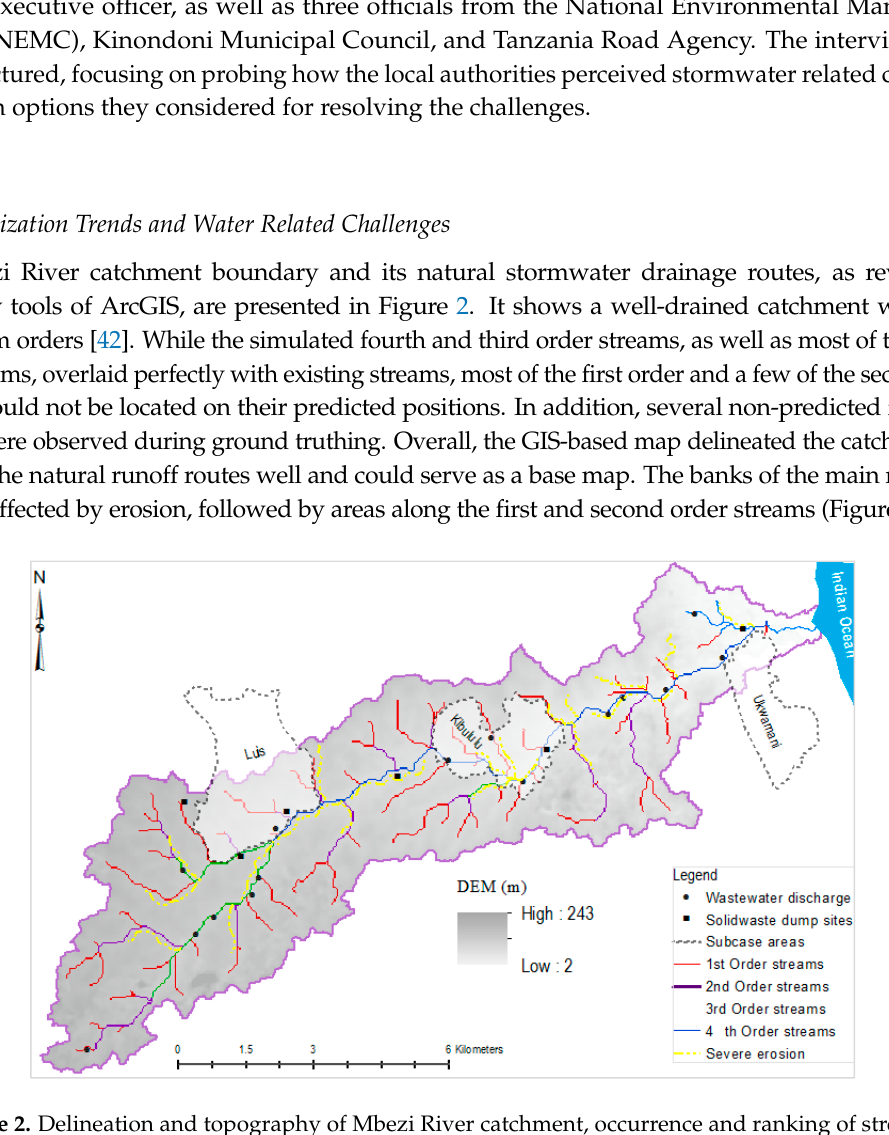
Table 1. Criteria for assessing man-made infrastructure drainage service. Modified from [41].